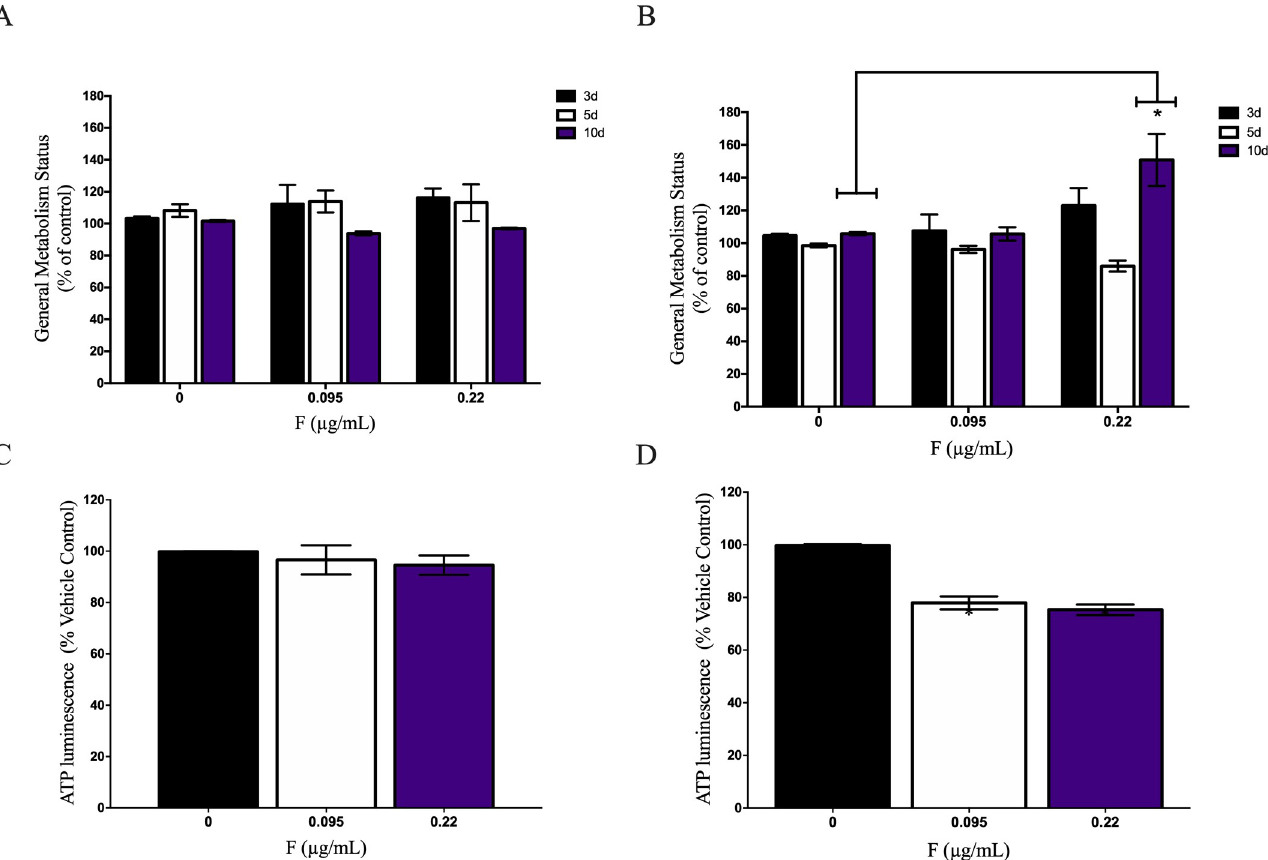
Fig 3. General cell metabolism (GCM) status of A) IMR-32 and B) U87 cells were performed by MTT assay in different times and F concentrations. GCM was indicated as MTT absorbance divided by percentage of viable cells. ATP synthesis was evaluated on C) IMR-32 and D) U87 after 10 days of 0.095 and 0.22 μ g/mL F. Data were expressed as mean ± SD. Statistical analysis was performed by one-way ANOVA followed by Tukey’s test. Statistical significance compared to control group was showed by � when p < 0.05.